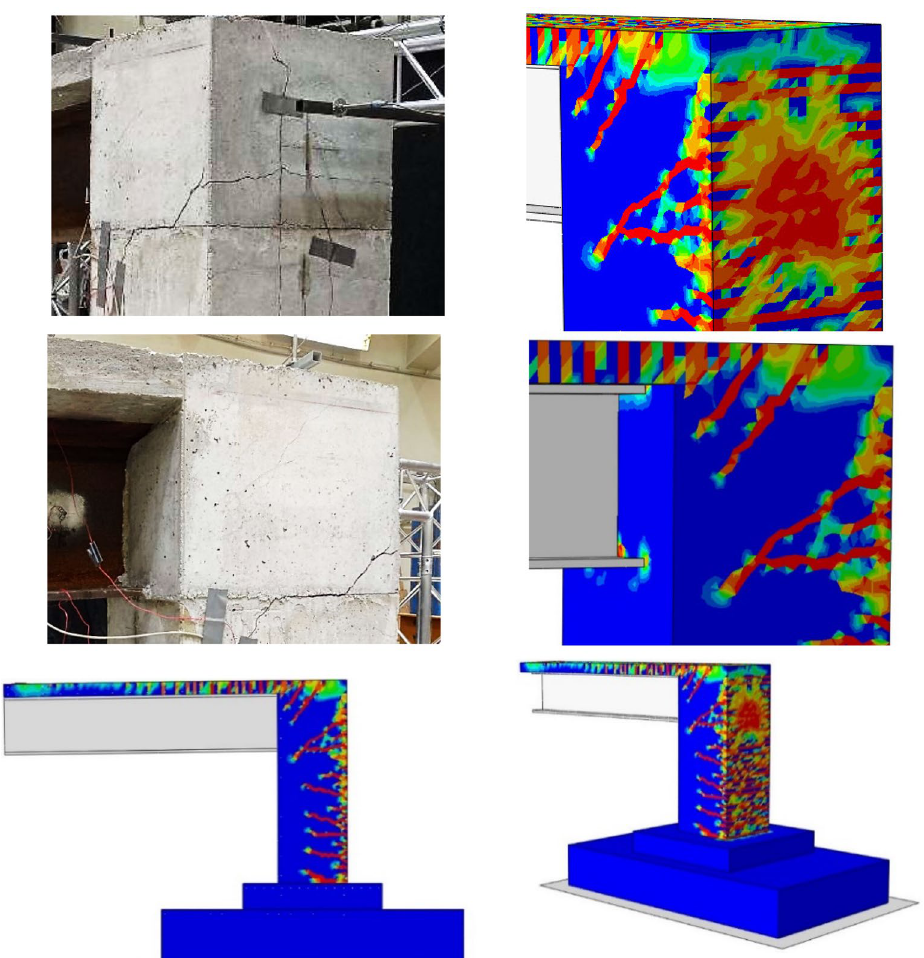
Figure 10. Experimental and numerical cracking patterns.